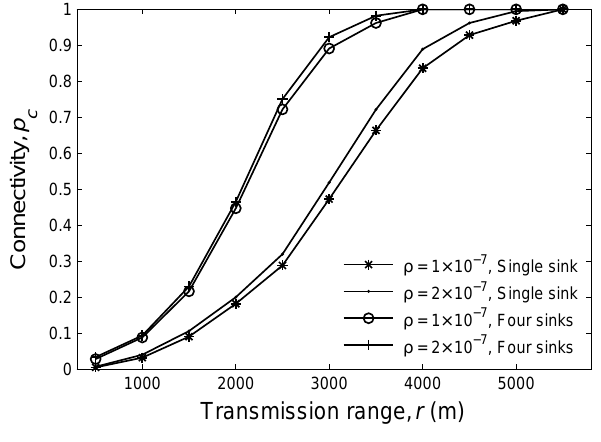
Figure 7. The simulation results of the network connectivity versus transmission range for single and multiple sink